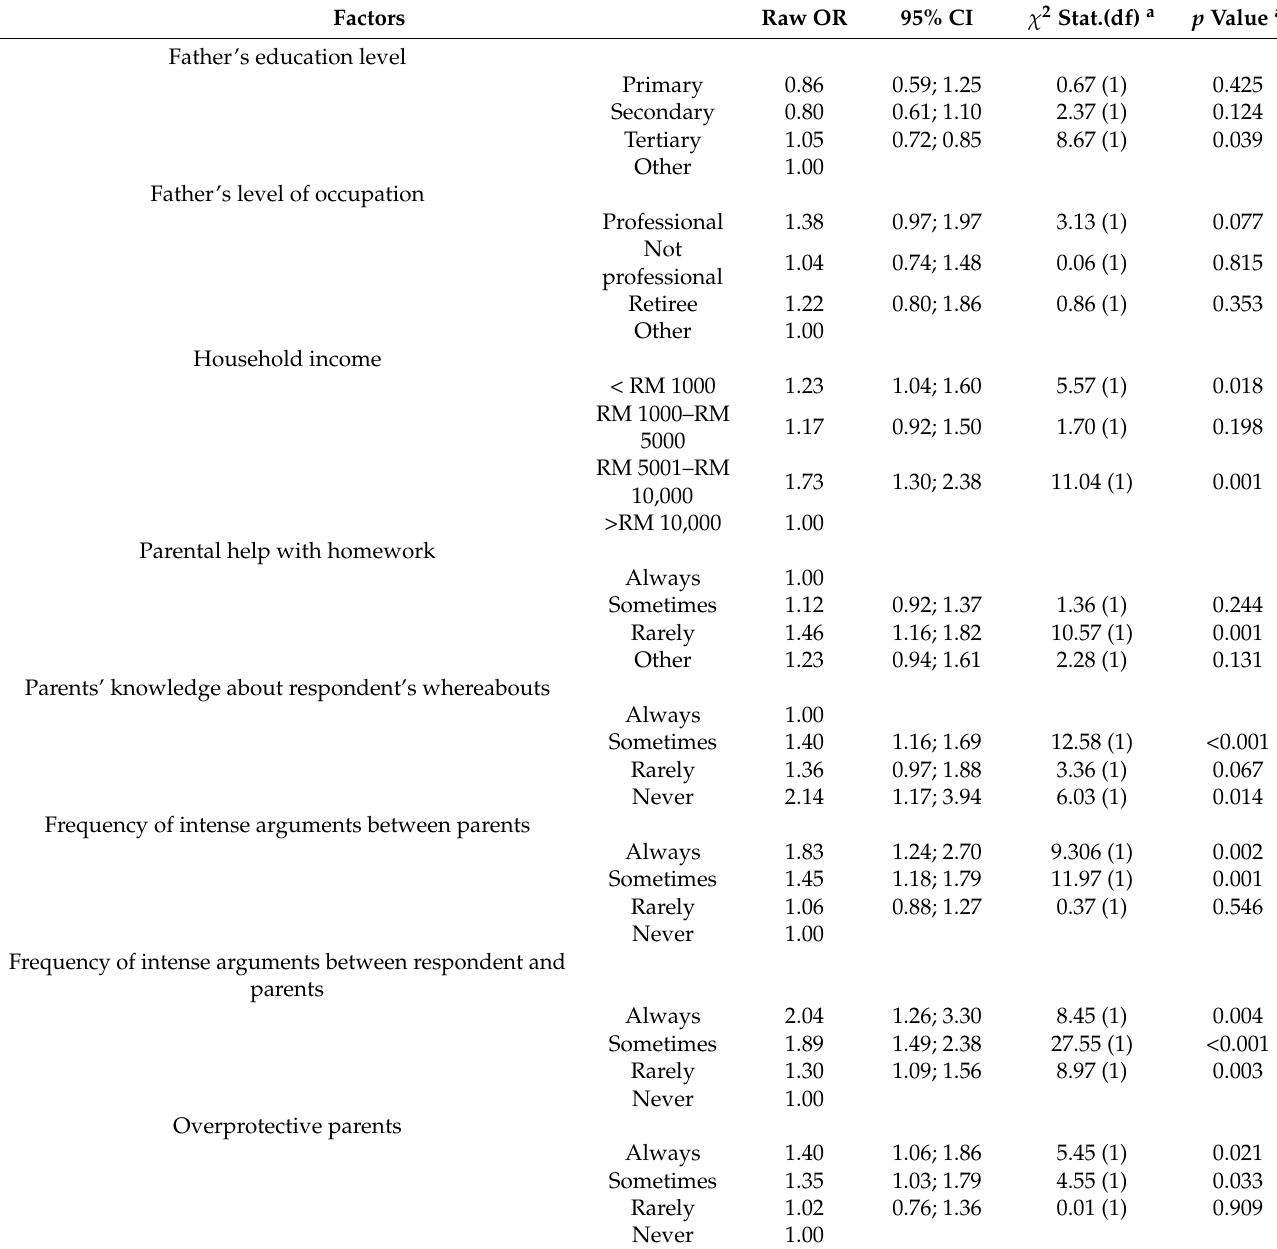
Table 7. Characteristic of family factors associated with bullying